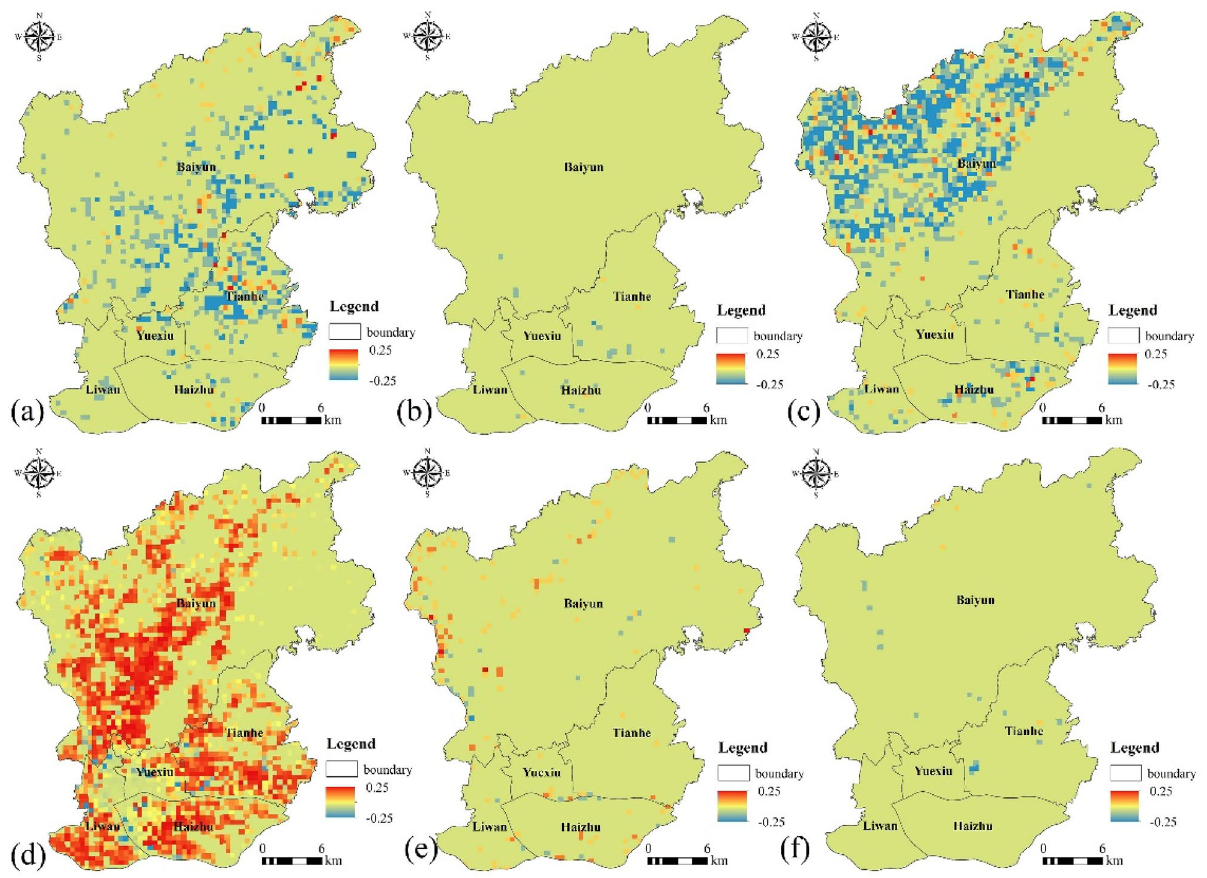
Figure 7. Spatial change of land cover types in the study area between 1987 and 2017. ( a ) forest, ( b ) grassland, ( c ) cultivated land, ( d ) built-up area ( e ), water body and ( f ) bare land. (Software: Arc Map 10.5.0, http://www. esri.com).